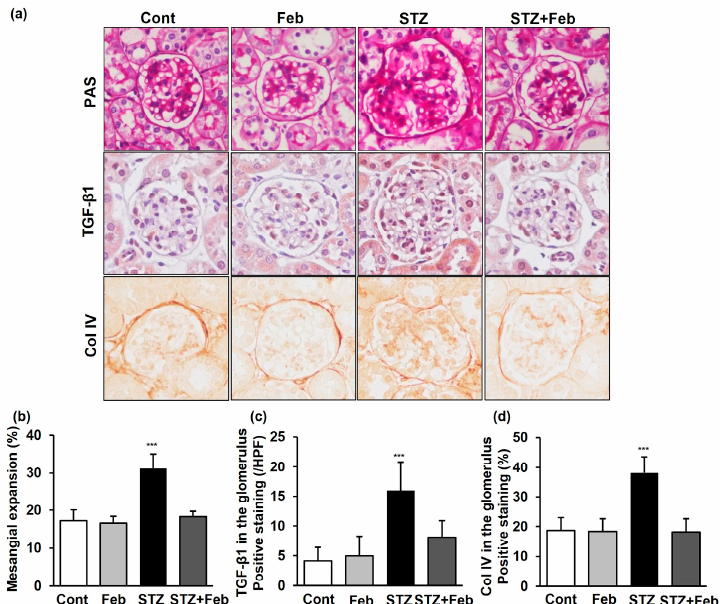
Figure 2. Changes in the glomerular phenotype in STZ-induced diabetic mice with or without febuxostat treatment. ( a ) Representative sections stained with periodic acid–Schiff reagent and representative immunohistochemical staining for TGF- β 1 and type IV collagen (original magnification 400×). ( b – d ) Quantitative analyses of the results for mesangial fractional area (%), TGF- β 1 and type IV collagen (fold) *** p < 0.001 vs. other groups.